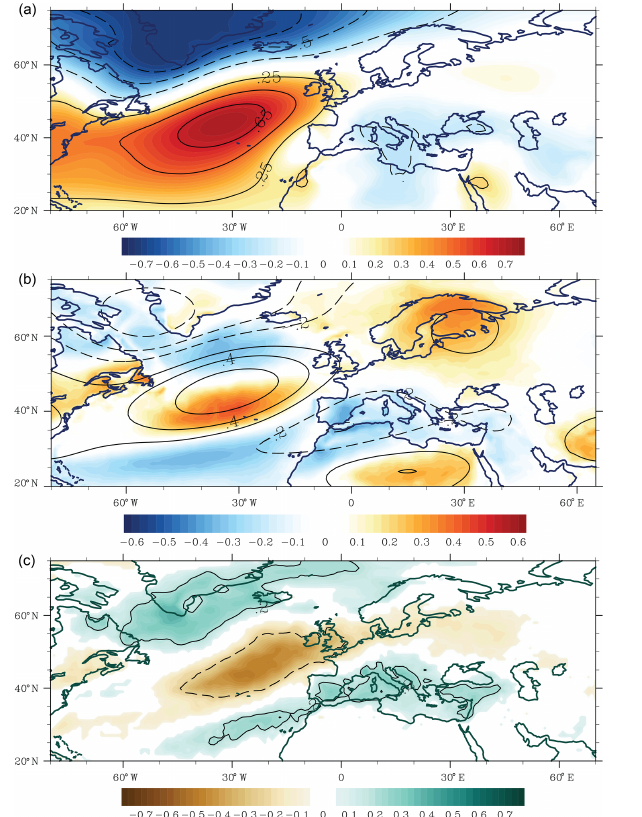
Figure 4. Correlation between principal component time series of the SNAO SLP in JA and (a) sea level pressure, (b) temperature at 2m (shaded) and geopotential height at 850hPa (contours), and (c) precipitation. All derived from the CTRL run. Contours in (a) and (c) are shown for 0.25 and 0.5 correlations. Correlations are shown only when significant at the 1%